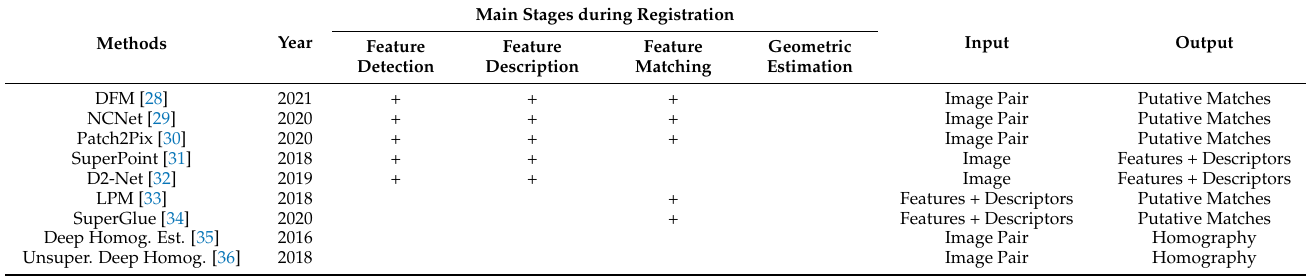
Table 2. A brief overview of state-of-the-art image registration methods. The particular stages that each method handles in the chain of the registration process are also presented along with the inputs and outputs. (+ indicates that the algorithm covers that stage.).